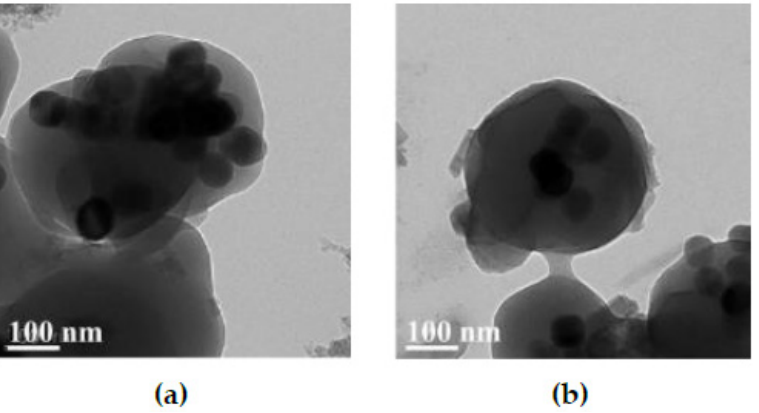
Figure 3. TEM images of UCNPs@MIP. Albumin ( a ) and hemoglobin ( b ) as templates.